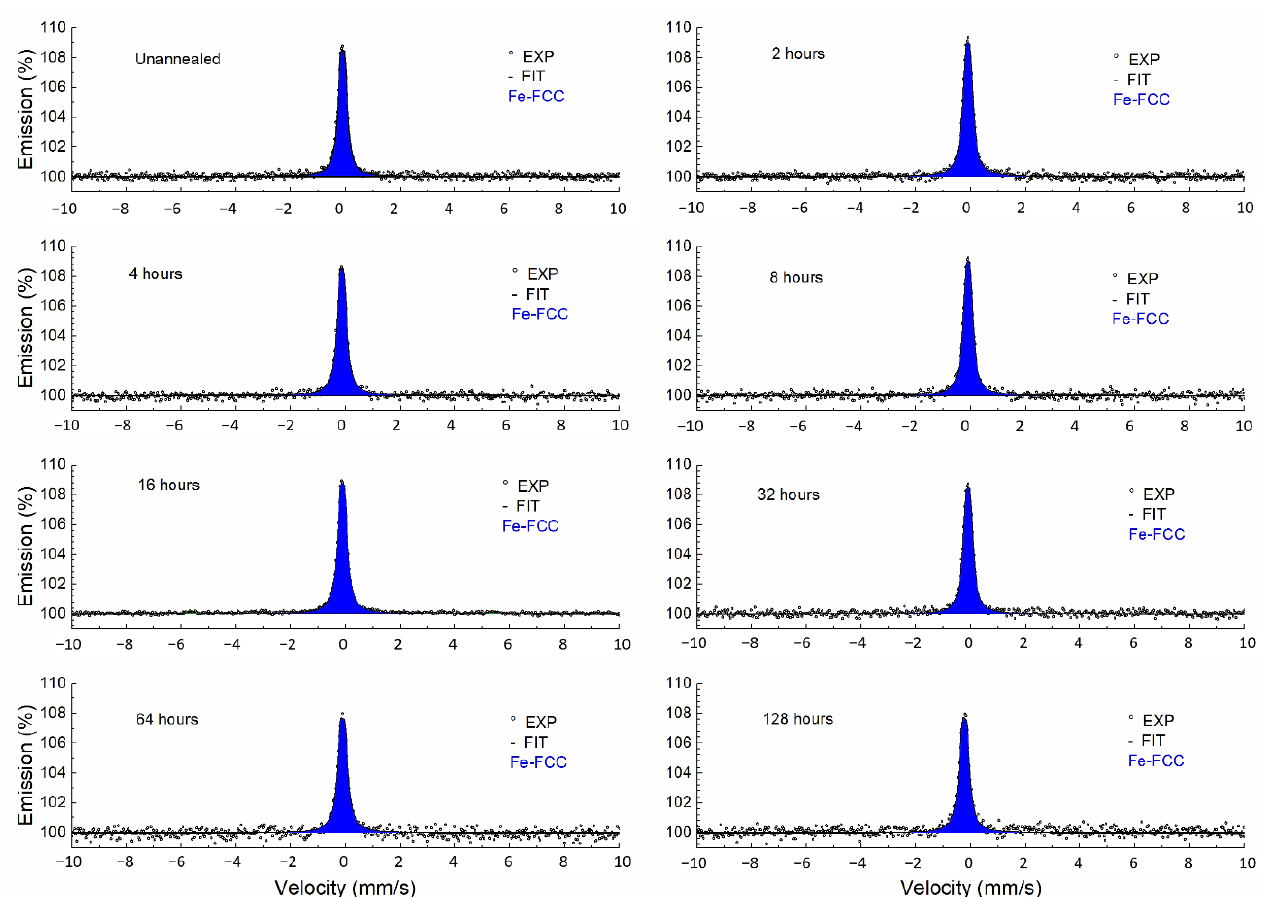
Figure 4. Conversion X-ray Mössbauer spectra of sample annealed at 550 °C for 16 h (measured for 430 h).